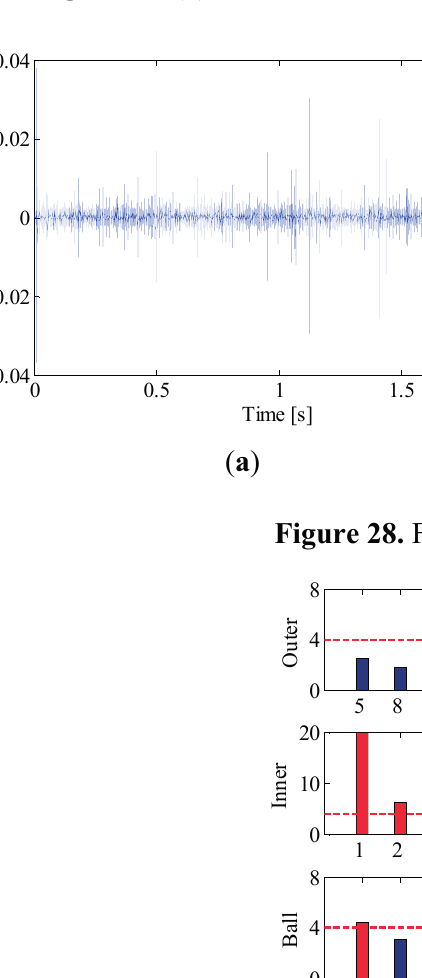
Figure 27. ( a ) Waveforms and ( b ) envelope spectrum of the band-pass filtered signal.